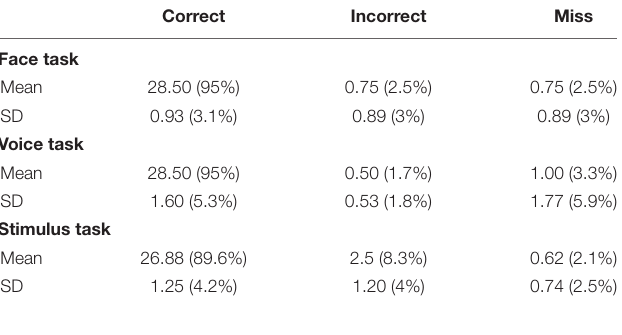
TABLE 2 | Results of the behavioral task during fMRI recording. Correct